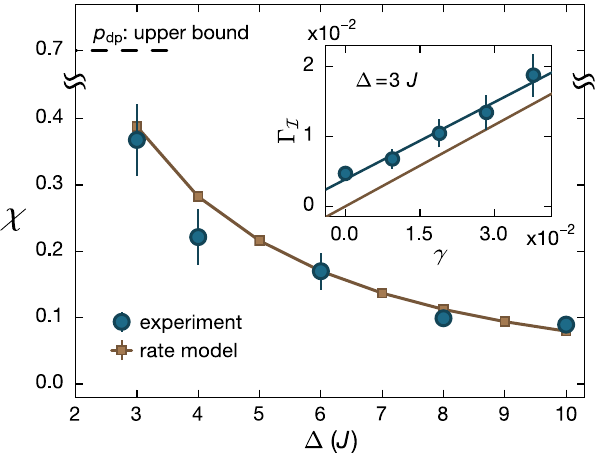
FIG. 3. Noninteracting susceptibility vs disorder strength: Susceptibilities for both the rate model and the experiment. Error bars indicate the fit uncertainty. The black dashed line indicates the upper bound of χ ≤ p . The inset shows measured imbalance dp decay rates Γ I as a function of the scattering rate γ at Δ ¼ 3 J . We observe a linear behavior, the slope of which is directly given by χ . We compare the data to the predictions of a rate model [31], indicated by the brown line, which is parallel to the fit through the experimental data. Hence, experiment and theory give the same susceptibility. The offset is caused by the constant background decay Γ in the bg